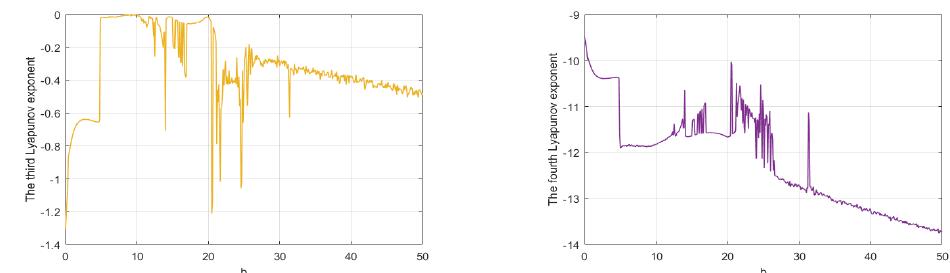
Figure 8. Spectrum of Lyapunov exponents for b ∈ [ 0,50 ] .